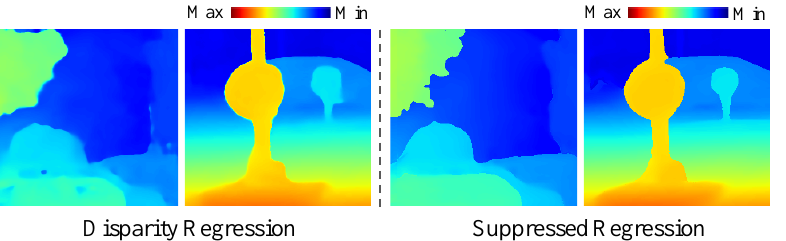
Figure 6. Comparison of the disparity regressions. The disparity maps are generated by the general regression ( left ) and suppressed regression ( right ). The disparity maps are visualized by colors ranging from blue (minimum disparity) to red (maximum